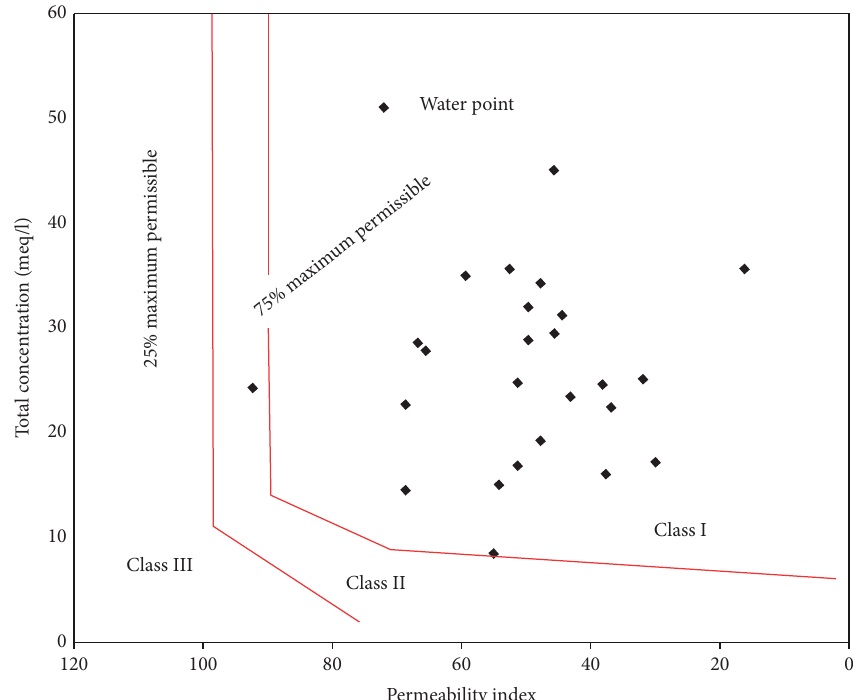
Figure 23: Wilcox diagram represents the quality of the Yisr catchment groundwater based on the permeability